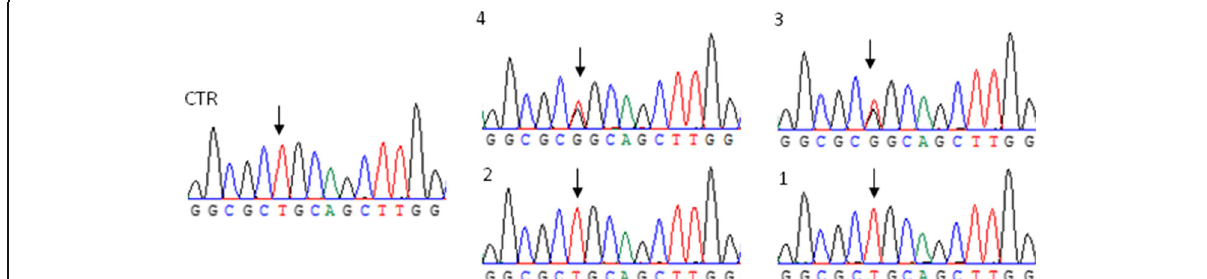
Fig. 4 SNP genotyping. The sequence chromatograms comparing the probands (1 and 2) and the healthy control (CTR) that are homozygous for rs223332 and the parents (3 and 4) that are heterozygous for rs223332. The black arrows indicates the heterozygous and homozygous